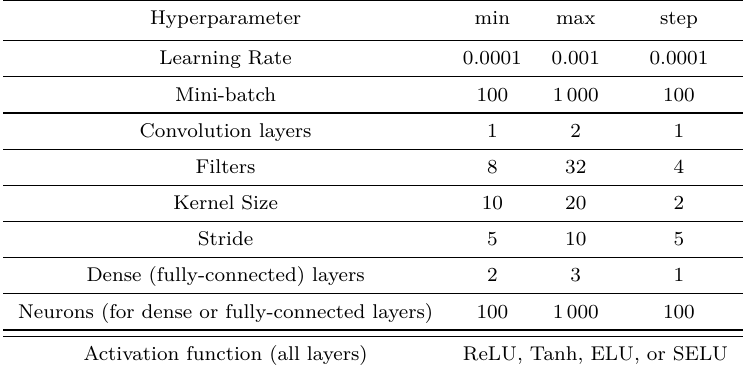
Table 3: Hyperparameters search space for convolutional neural network.